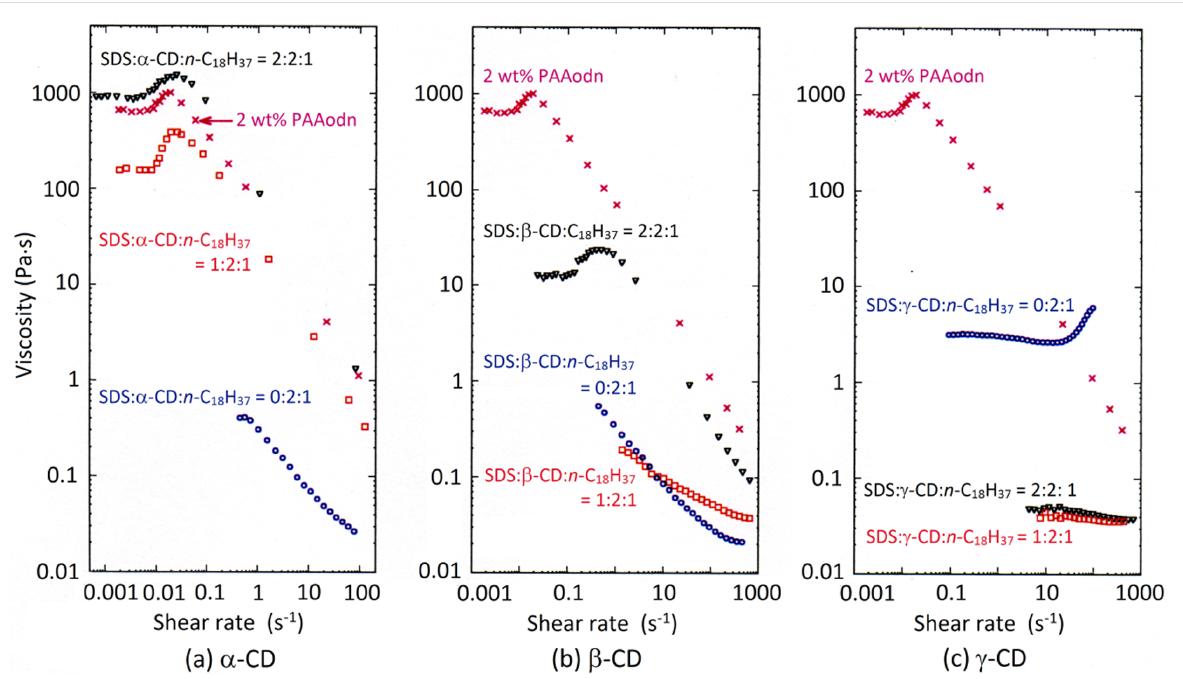
Figure 5: The effect of SDS addition on viscosity shear rate dependence for 2 wt % aqueous PAAodn solutions containing (a) α -CD, (b) β -CD and (c) γ -CD with a molar ratio of CD to n -C 18 H 37 = 2:1 (0.10 M NaCl, pH 7.0). Data sets are shown for 2 wt % PAAodn alone (crosses) and for the ratios: SDS:CD: n -C 18 H 37 = 0:2:1 (circles), SDS:CD: n -C 18 H 37 = 1:2:1 (rectangles) and SDS:CD: n -C 18 H 37 = 2:2:1 (triangles). Adapted with permission from [46]. Copyright (2008) American Chemical Society.